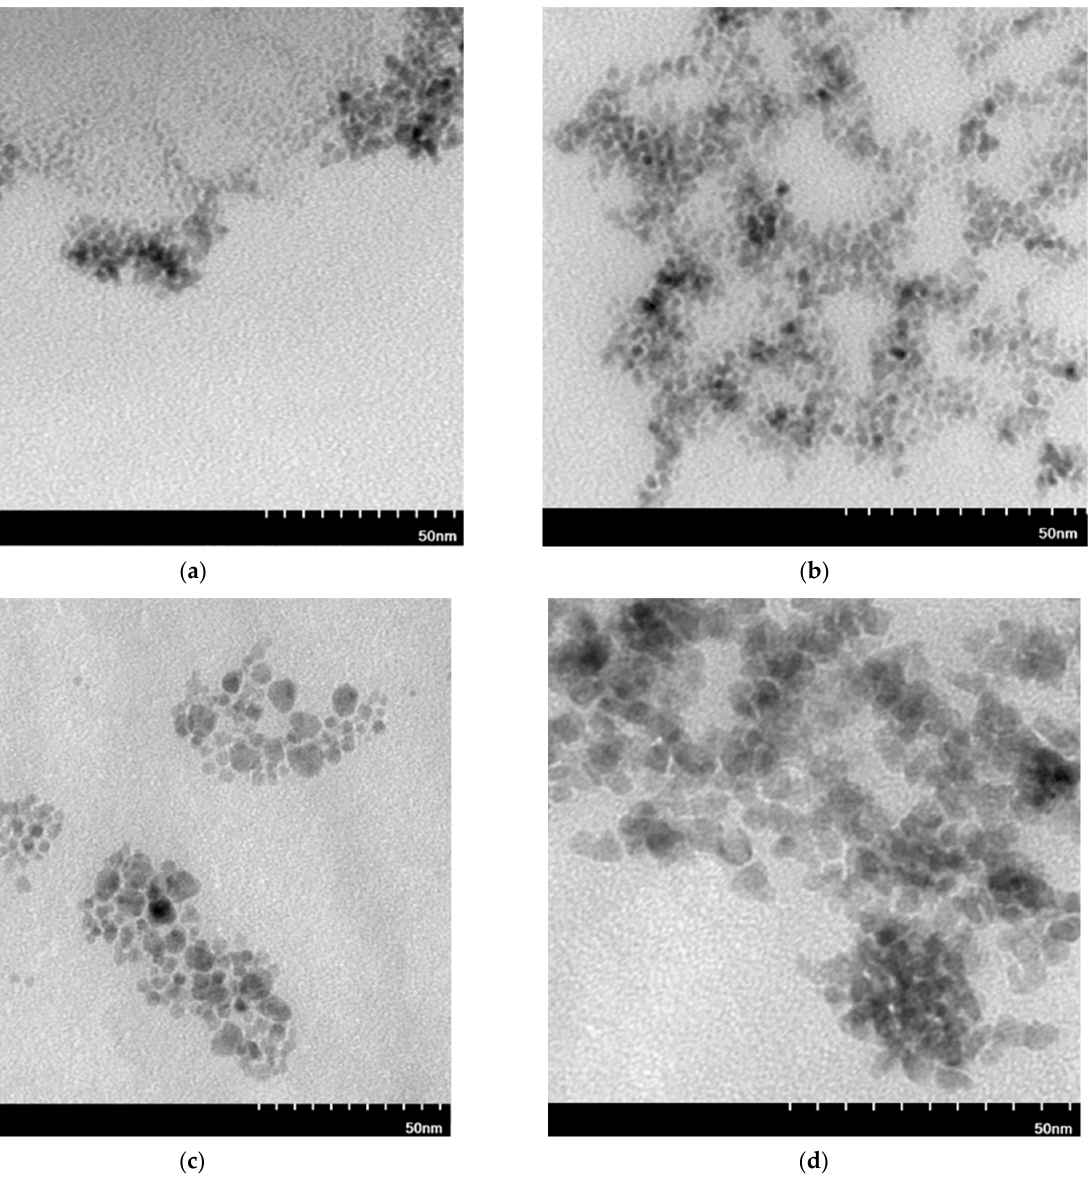
Figure 6. Transmission electron microscopy (TEM) images of Pt/Rh-NP ( a , b ) and Pd/Rh-NP (c,d) (the molar ratio of PGM:PVP:reducer was 1:1:1) using AA for ( a , c ) and NaBH 4 for ( b , d